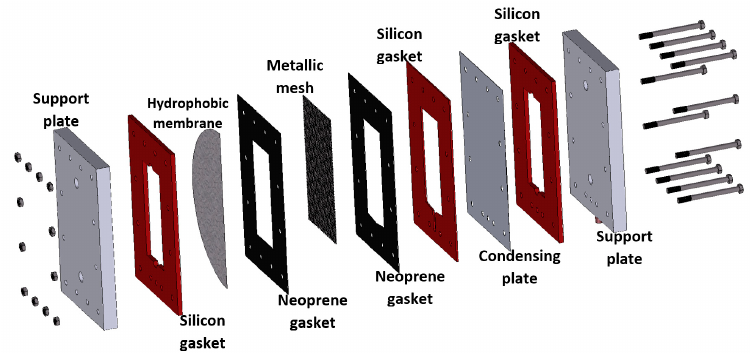
Figure 2. Membrane desorber/condenser module.